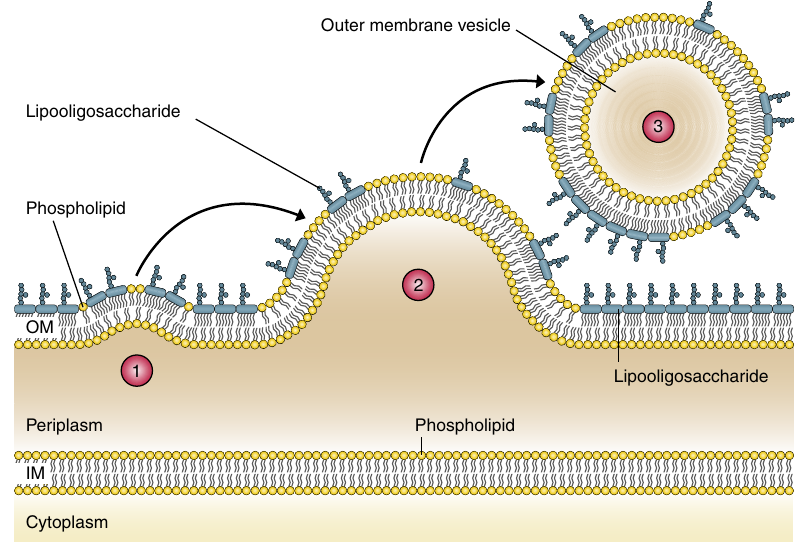
Figure 8 | A new model of OMV formation in Gram-negative bacteria. Step 1: Decreased expression or deletion of vacJ and/or yrb genes results in PL accumulation in the outer leaflet of the OM. This asymmetric expansion of the outer leaflet initiates an outward bulging of the OM. Step 2: Further enrichment of positive and negative curvature-inducing PLs in both leaflets supports the budding of the OM, which finally pinches off to form an OMV. Step 3: The released OMV is enriched in PLs incorporated into the outer leaflet of the vesicle